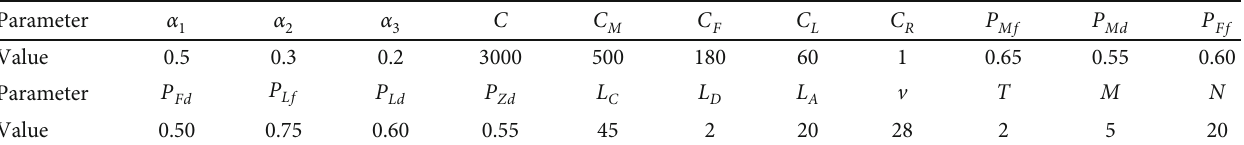
Table 1: Model parameter values.